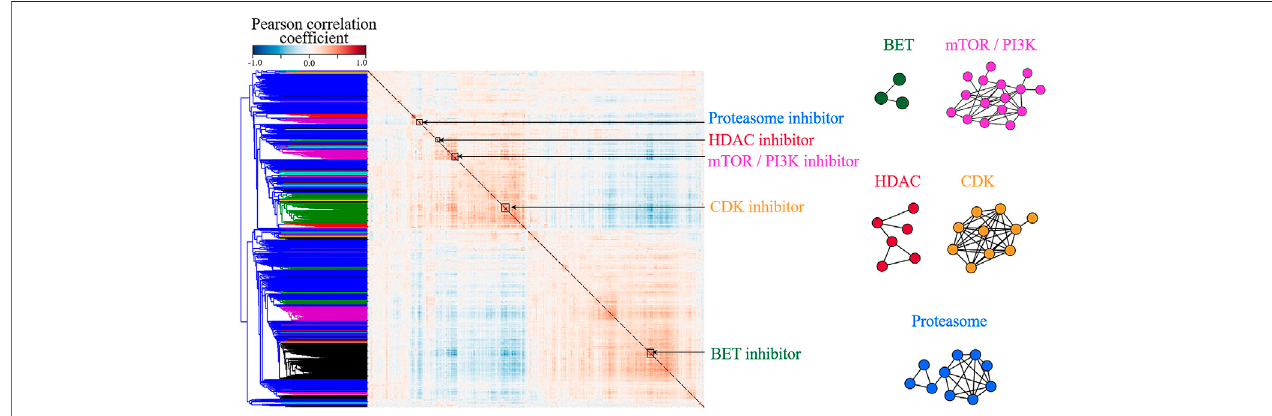
FIGURE 2 | The clustering of small molecules according to their L1000 consensus signatures. (A) Correlation matrix of the 918 consensus signatures. Blue to red denotes the correlation coef fi cient between the two compounds from − 1 to 1, namely, from completely negative correlation and the completely positive one. The red clusters along the diagonal denote compounds with high transcriptional similarities (Pearson Correlation > 0.7). (B) Networks of highly correlated Library of Integrated Network-basedCellularSignaturescompounds.ThenodesinthenetworkrepresentL1000smallmolecules.Ifthecorrelationcoef fi cientbetweentwocompounds isgreaterthan0.7,theyareconnectedbyaline.Thecolorofthenetworkiscorrespondingtotheclusterannotationin (A) .Forexample,bluenodesin (B) areProteasome inhibitors, corresponding to the blue cluster in (A) . Compound names and mechanisms of action are shown in Supplementary Table S1